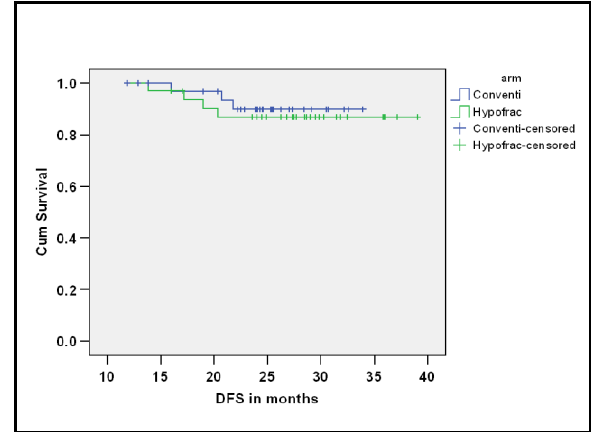
Figure 1: Kaplan Meier disease-free survival